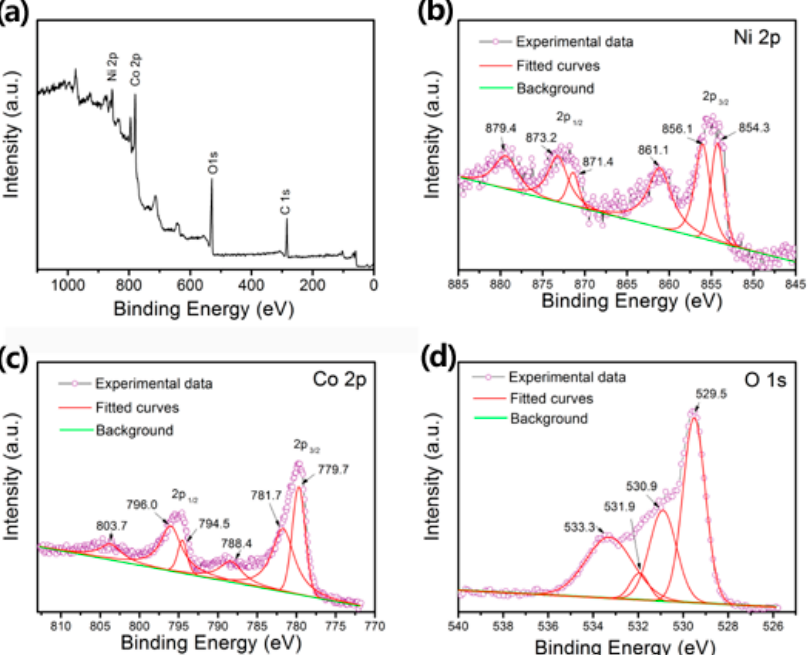
Figure 4. ( a ) Low-magnification transmission electron microscopy (TEM) image; ( b ) high-magnification TEM image, ( c ) high-resolution TEM (HRTEM) image of enlarged part marked by red square in ( b ), ( d ) elemental mapping, and ( e ) energy dispersive spectrometer (EDS) spectrum of single NiCo 2 O 4 nanowire.